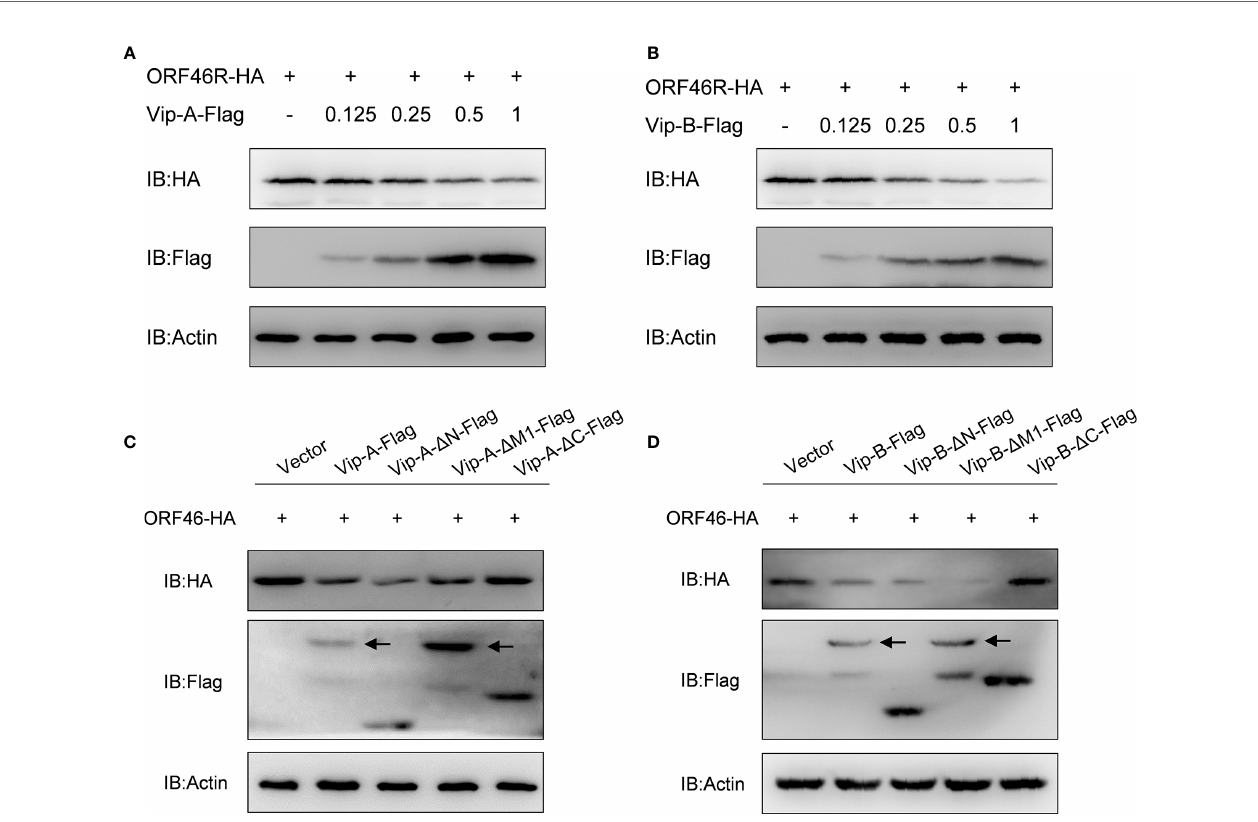
FIGURE 6 | Overexpression of Cg Viperin-A and Cg Viperin-B induce the reduction of Ca HV ORF46R protein via its C-terminus. (A, B) Overexpression of Cg Viperin- A (A) or Cg Viperin-B (B) induced the reduction of ORF46 protein in a dose-dependent manner in CAB cells. CAB cells were transfected with the indicated expression vectors and harvested for western blot analysis after 18 – 24 h (C, D) Domain mapping for Cg Viperin-A (C) or Cg Viperin-B (D) domains acting on ORF46R. CAB cells were transfected with the indicated expression vectors (2 m g/well) and harvested for western blot analysis after 18 – 24 h Diagrammatic representation of three mutants of Cg Viperin-A or Cg Viperin-B is shown in Figure 3B . Data are presented based on three independent